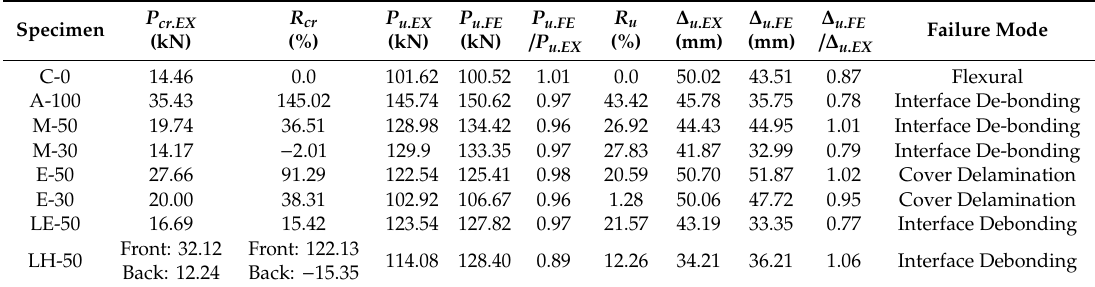
Table 3. Comparison of loads and failure mode